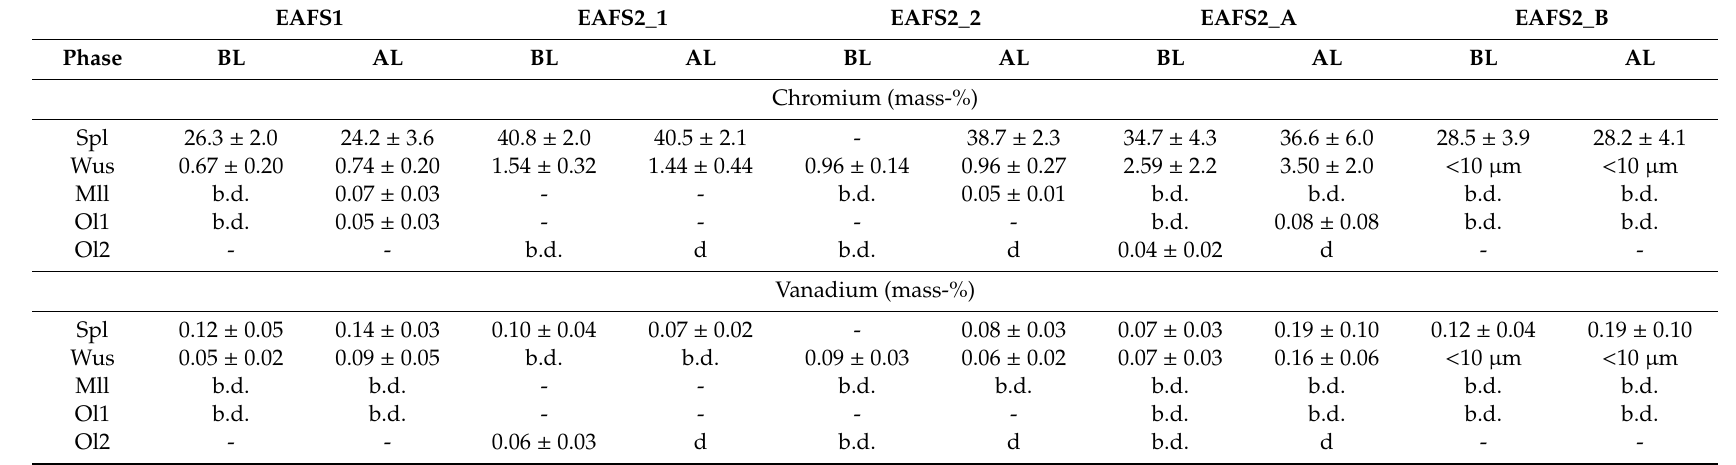
Table 3. Mean concentrations of Cr and V of all measured phases (see Table 2) before (BL) and after leaching (AL) for spinel solid solutions (Spl), wuestite solid solutions (Wus), melilite group phases (Mll), and olivine group phases (Ol); (s = 1 σ ). Abbreviations: no analyzed grain (-), below detection limit (b.d.), and dissolved (d). Results of the chemical mineral analyses of single grains are listed in Tables